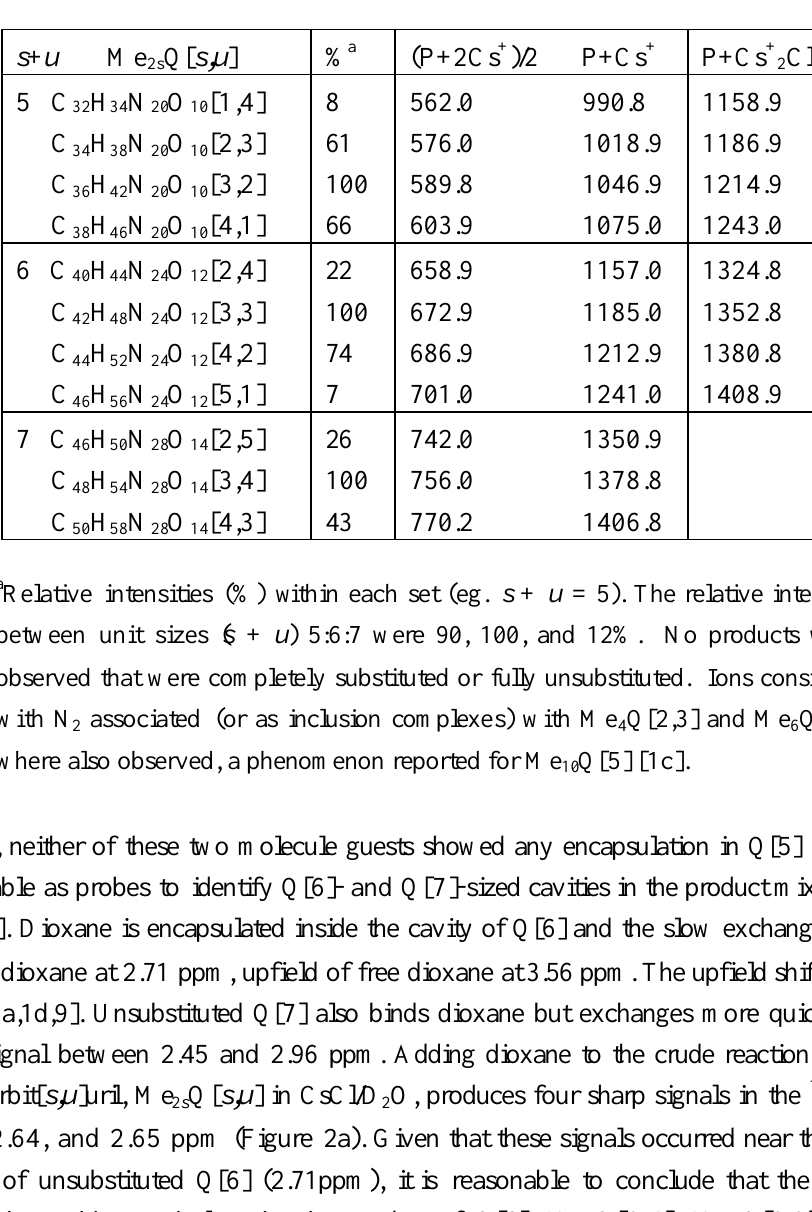
Table 1. ESMS spectral ions observed for the partially substituted cucurbit[ s,u ]uril at 100